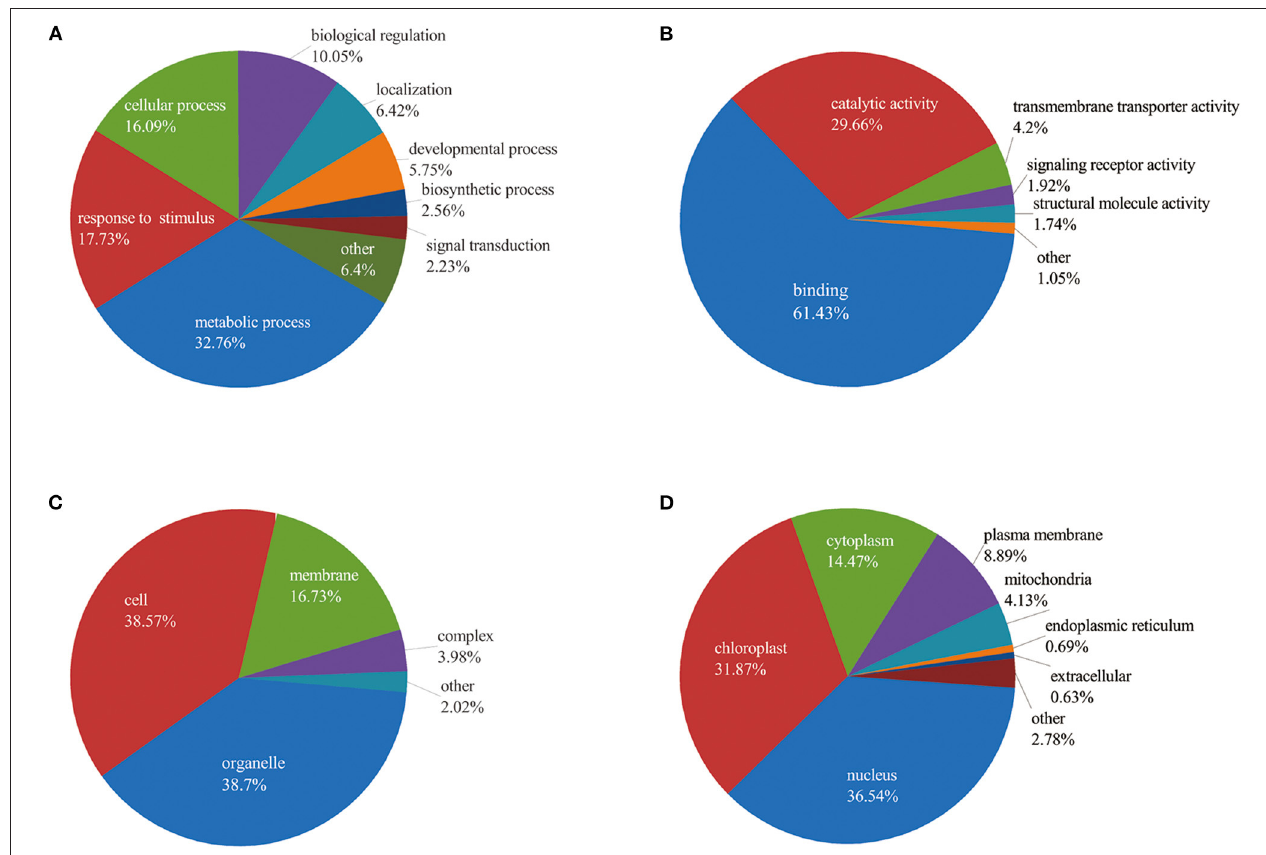
FIGURE 4 | Functional classification of phosphorylated proteins in barley roots based on: (A) biological process; (B) molecular function; (C) cellular component; and (D) subcellular localization of phosphorylated proteins.